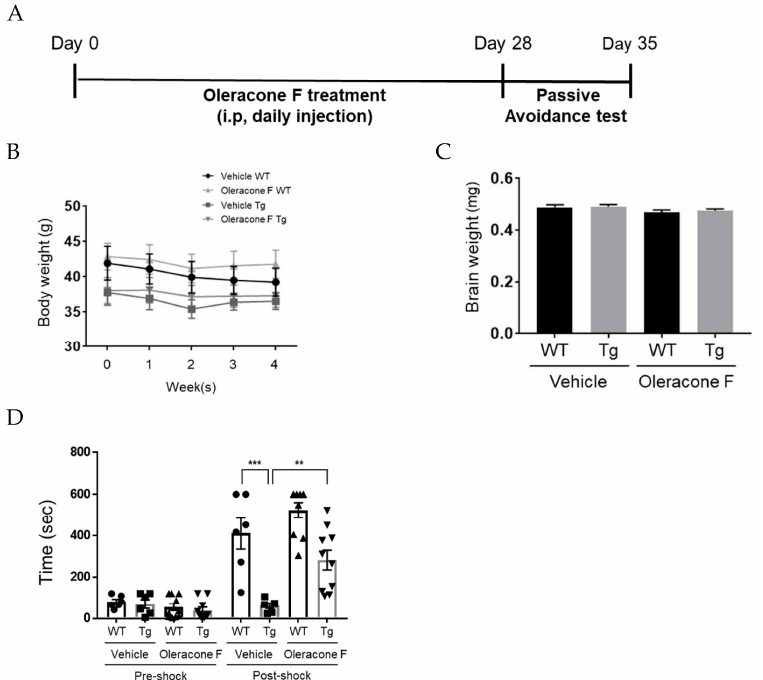
Figure 3. The administration of oleracone F attenuated cognitive impairment in AD transgenic mice. ( A ) Experimental designs are depicted. Wild-type (WT) and AD Tg mice were injected with vehicle (saline) or oleracone F (5 µ g/kg, i.p) for 4 weeks. ( B ) The body weight of WT mice was slightly heavier than Tg mice, but no difference between oleracone F-treated and untreated was found. ( C ) Total wet brain weight was measured. ( D ) Passive avoidance test was performed as described in Materials and Methods. The data are presented as the mean ± SEM. Statistical difference was determined by Student’s t -test, and the data are presented as the mean ± SEM (n = 6–10), ** p < 0.01, *** p < 0.001.